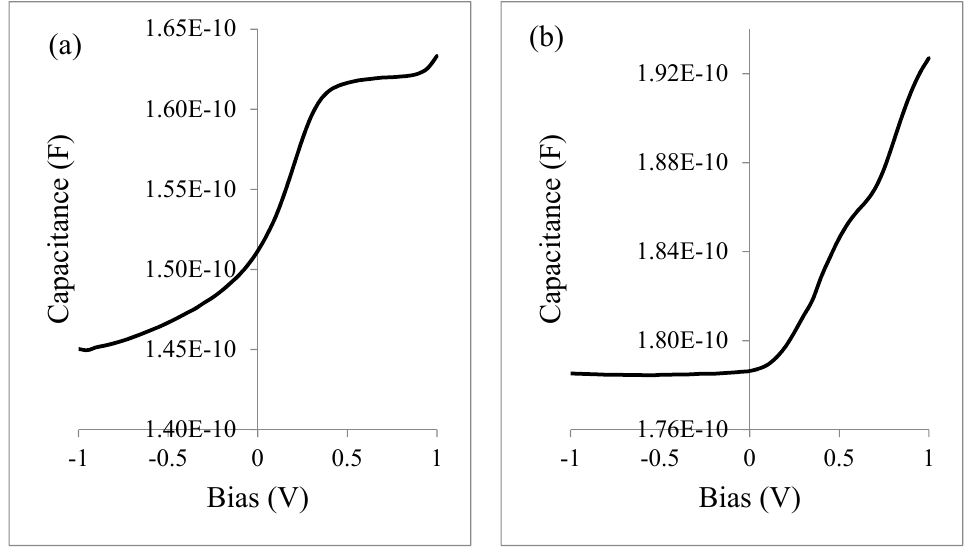
Figure 10. Capacitance-Voltage plot at a frequency of 1 MHz for ( a ) glass/FTO/ZnS/ CdS/CdTe/Au 3-layer device and ( b ) glass/FTO/CdS/CdTe/Au 2-layer